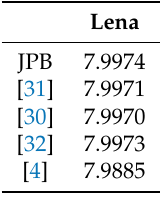
Table 4. Entropies of encrypted Lena using different algorithms.